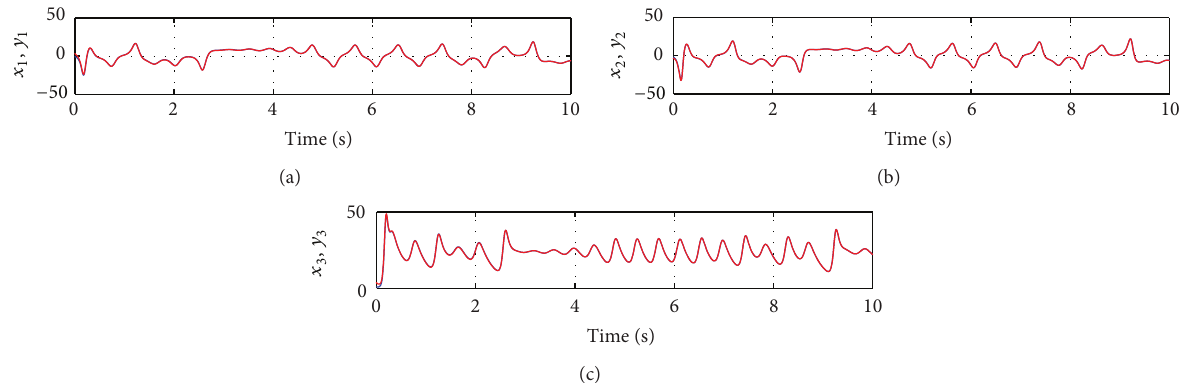
Figure 3: Synchronization of determined fractional-order unified chaotic system with 𝛼 = 0.5 (blue line represents the trajectories of the drive system, while red line represents the trajectories of the response system).